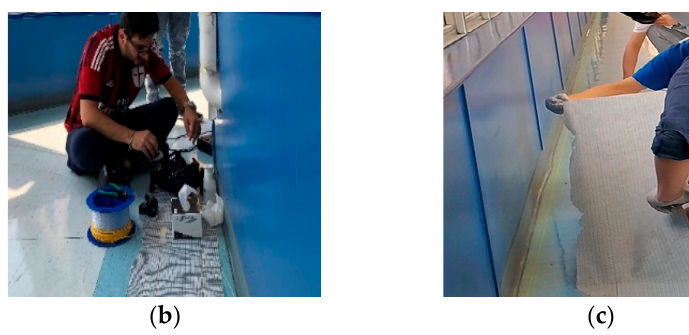
Figure 4. Location of installation.